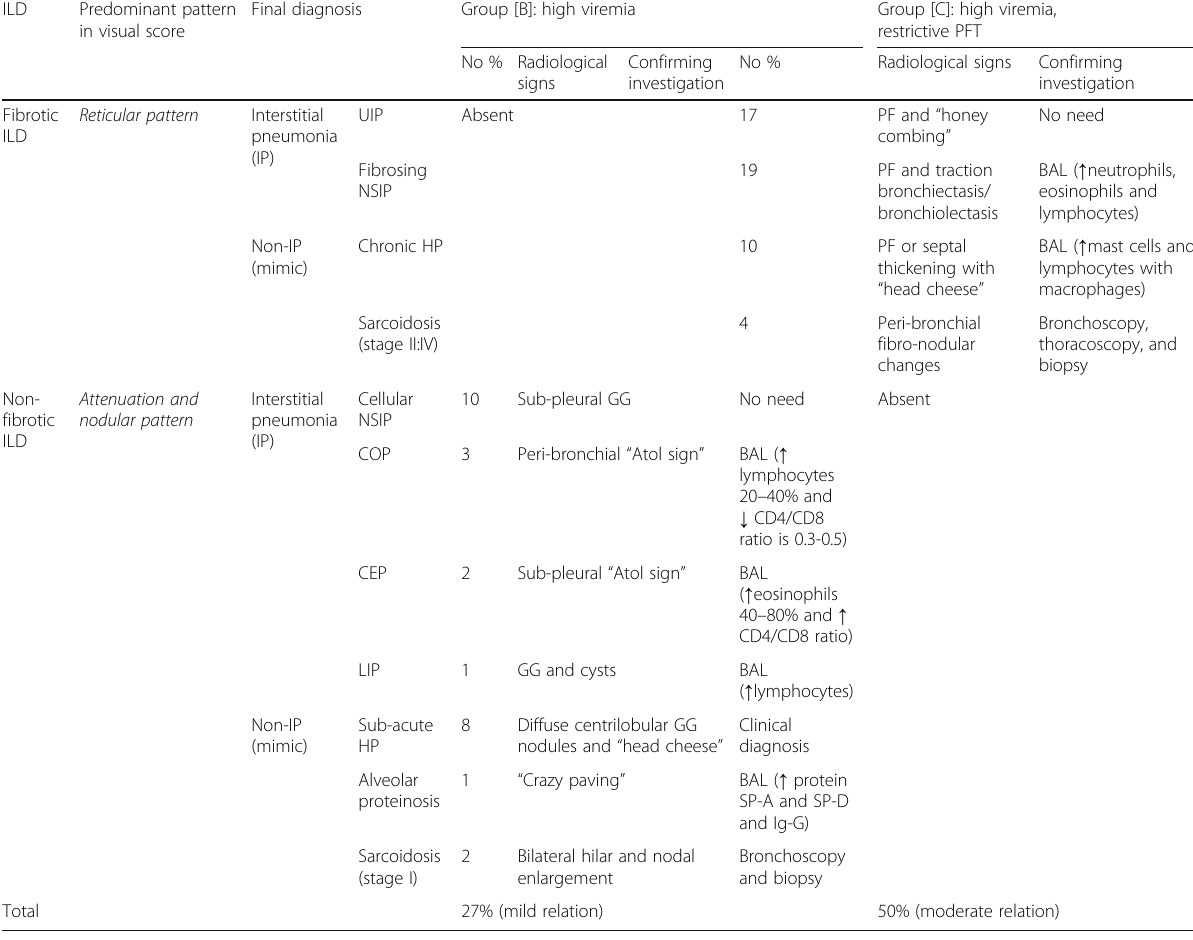
Table 1 Summary of results in group (B) and (C) including ILD characterization, % of patients involved, radiological signs, and further investigatory tools